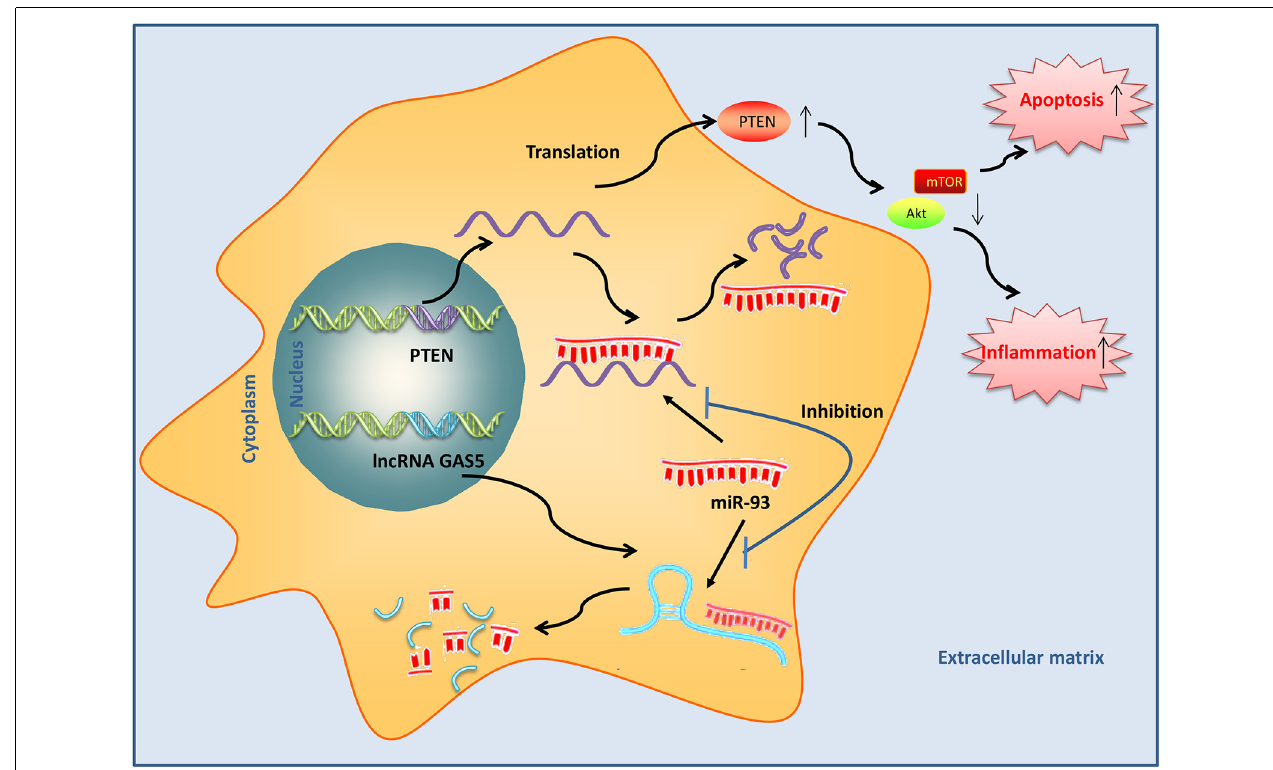
FIGURE 9 | Long noncoding RNA (lncRNA) growth arrest–specific transcript 5 (GAS5) induced by SCI acts as an endogenous sponge of miR-93 to promote phosphatase and tensin homolog (PTEN) protein expression and subsequently inactivates PI3K/AKT, thus resulting in the induction of apoptosis and inflammatory response in SCI